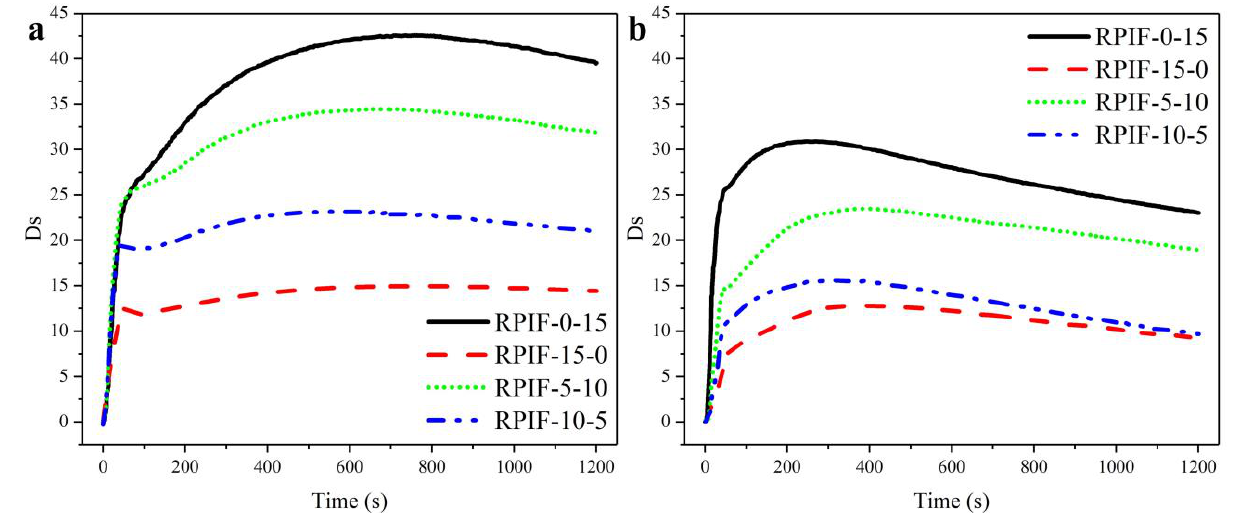
Figure 10. Ds curves of RPIF with total dosage of EG and PPCP at 15 wt. %: ( a ) test without flame condition, ( b ) test with flame